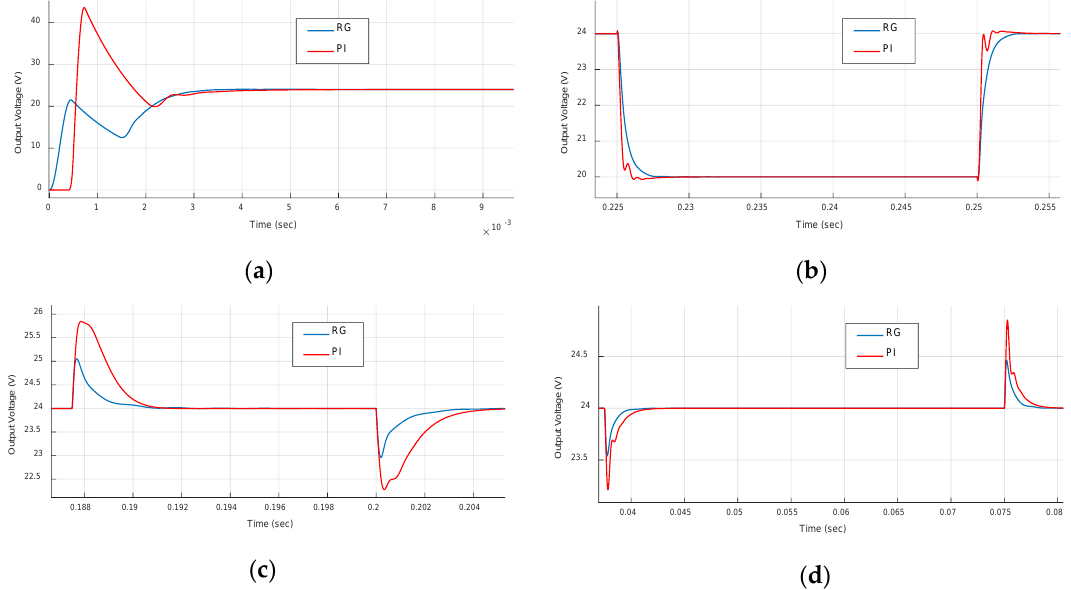
Figure 10. Comparative transient responses of the two PI designs of Table 3 with APP (PID + ROAPC). ( a ) Startup transient response for tracking a reference input of 24 V with an input voltage Vin = 12 V; ( b ) reference input changes from 24 V to 20 V and back; ( c ) rejection of load step changes (from 10 to 50 Ω and back); ( d ) dealing with step changes in the input voltage (from 12 to 10 V and back).